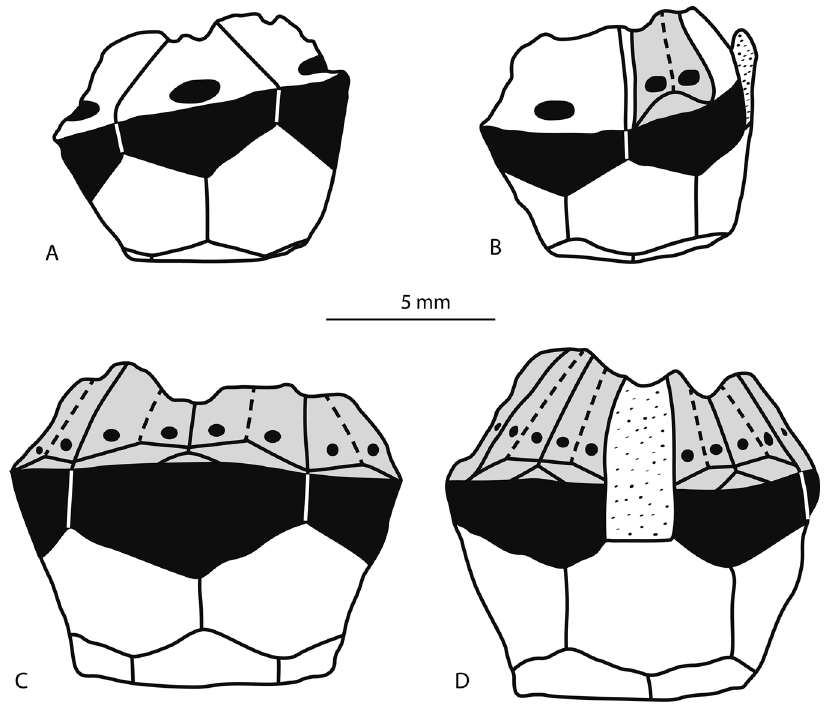
Fig. 3. Line drawings showing the arrangement of plates in Elgaecrinus uralicus sp. nov: A , B , paratype PIN3424/273, lateral view (A, ray A; B, interray DE); C , D , holotype PIN3424/274 (C, ray E; D, interray CD). Infrabasals, basals and facets of radials are white, radials are black, anals are stipped and brachials are